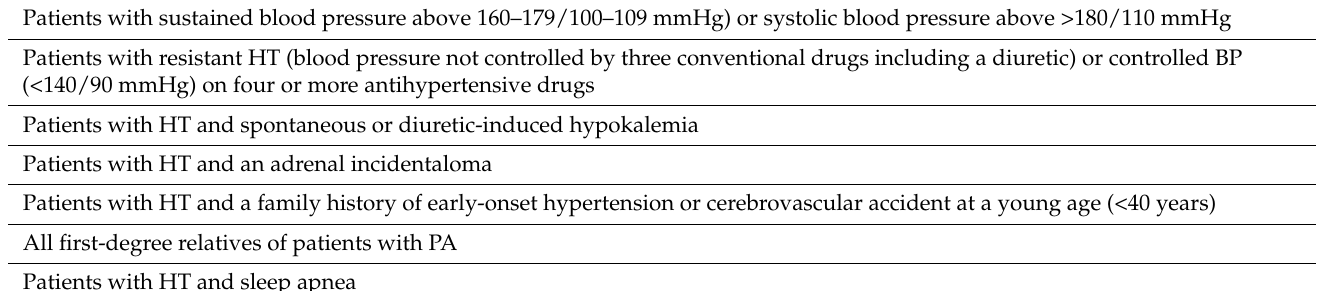
Table 1. Recommendation for PA screening